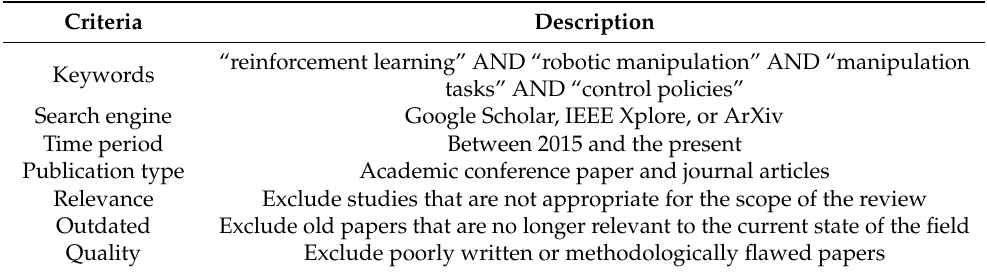
Table 1. An overview of the specified search criteria.